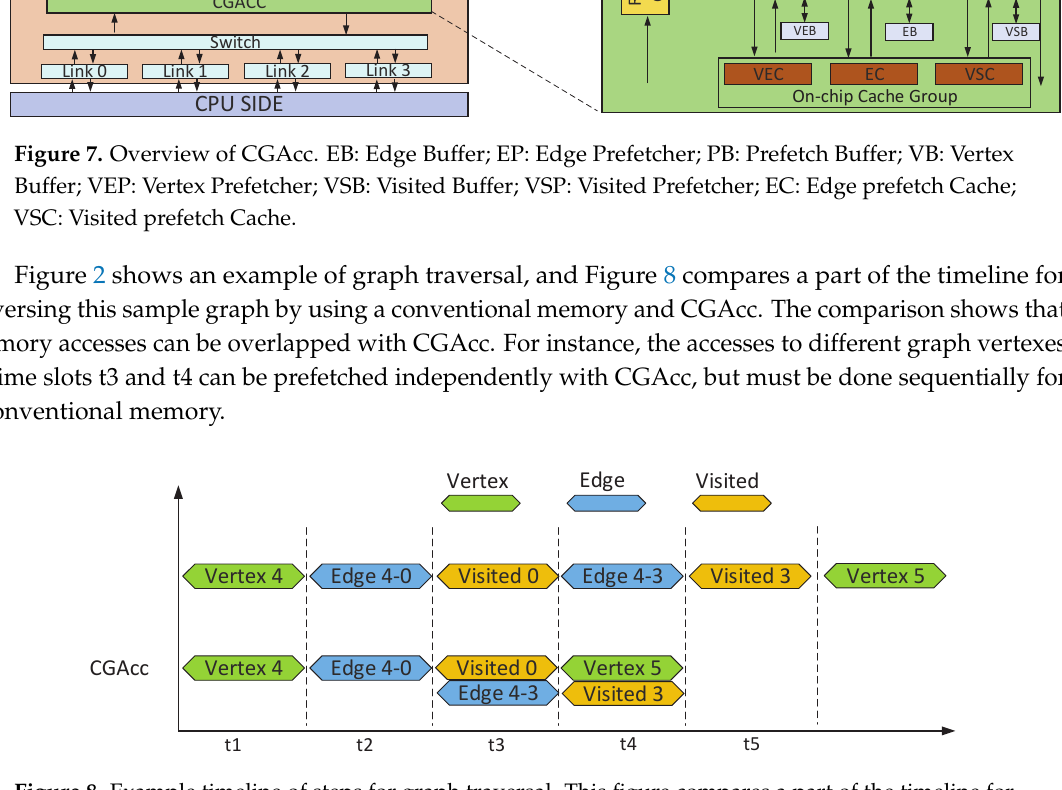
Figure 8. Example timeline of steps for graph traversal. This figure compares a part of the timeline for traversing the sample graph in Figure 2 by using a conventional memory and